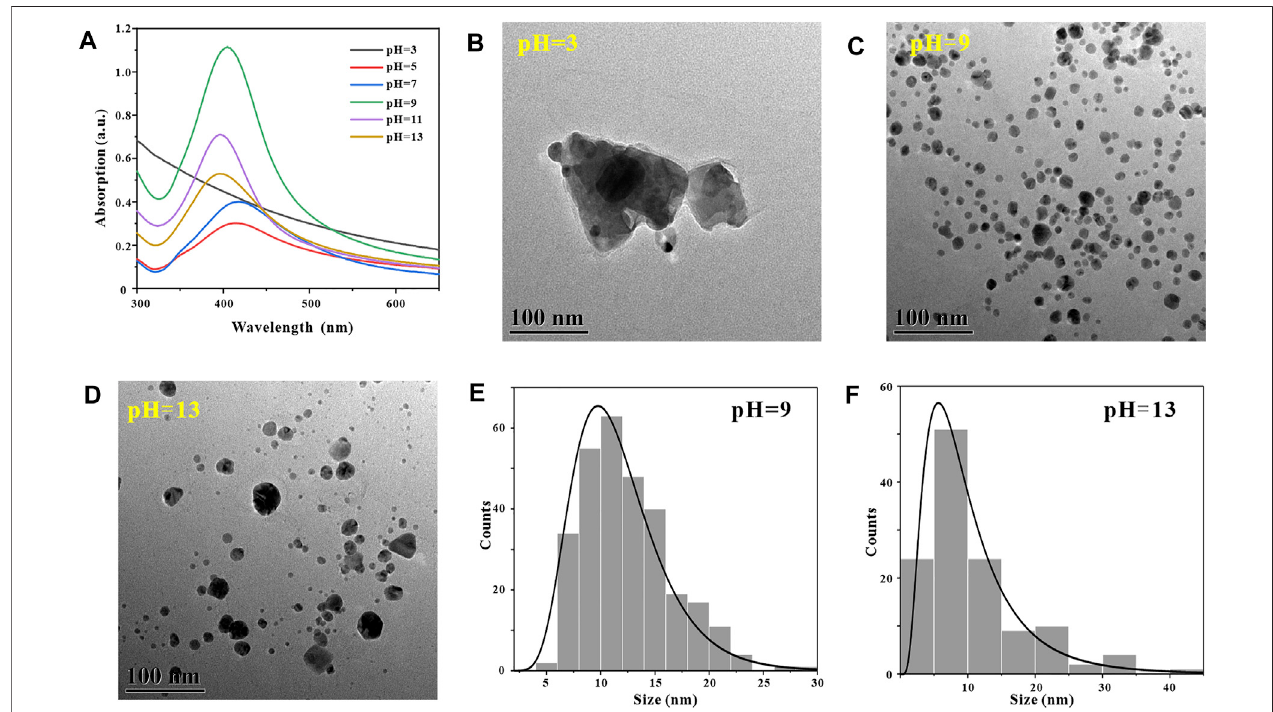
FIGURE2| Optimization ofreaction pH, UV-vis spectra ofGO-AgNPs under different reaction pHconditions (A) ,TEMimage ofGO-AgNPs at reaction pH = 3 (B) , pH = 9 (C) , pH = 13 (D) , panels (E,F) are the particle size distributions of AgNPs in panels (C,D) , respectively.